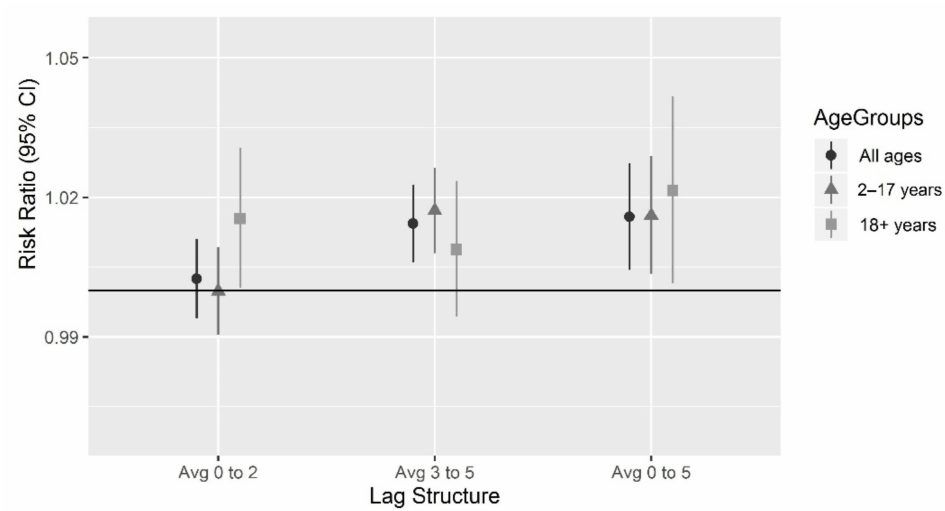
Figure 4. Risk ratios of respiratory ED visits in Mexico City corresponding to one interquartile increase in health-based index values, by lag structure and age group. The primary exposure window of interest is the 6-day average of lag days 0–5. The index values are significantly associated with population-level respiratory risk for both children and adults over the multi-day window of health impacts observed for the underlying individual pollutants. Examples of lag days 0–2 and lag days 3–5 represent the extreme differences in results observed between age groups. Other lag structures (i.e., lag days 1–3) are significantly associated with health risks in both populations at similar levels of relative